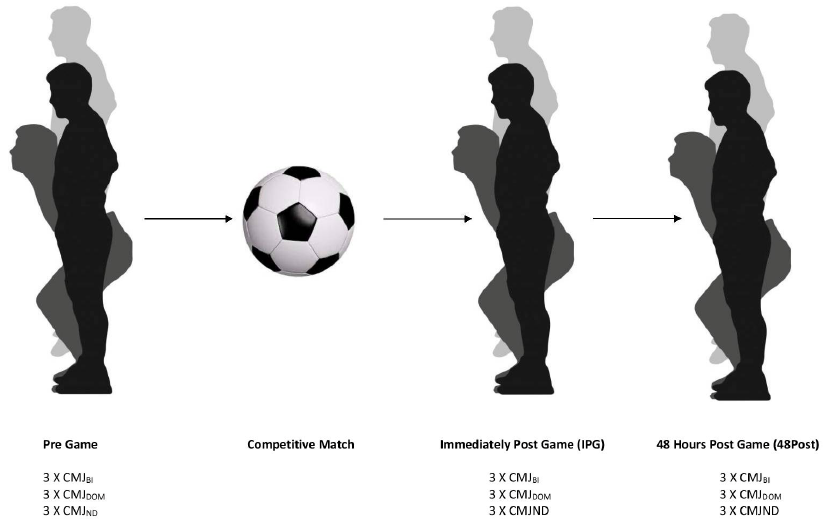
Figure 1. Visualization of experimental design of Study